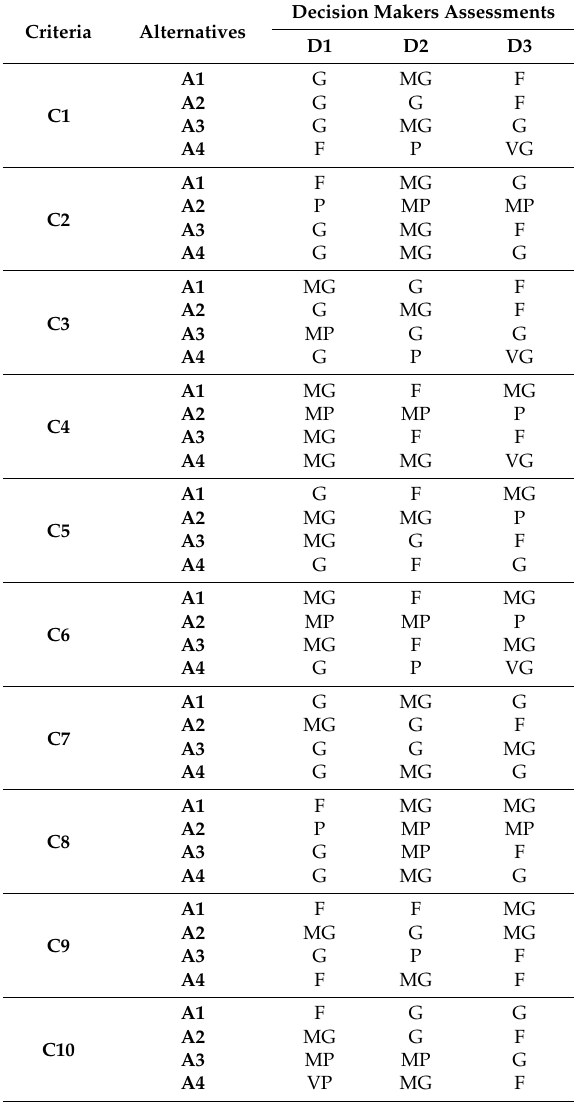
Table 6. Ratings of the four alternatives by three decision-makers under ten